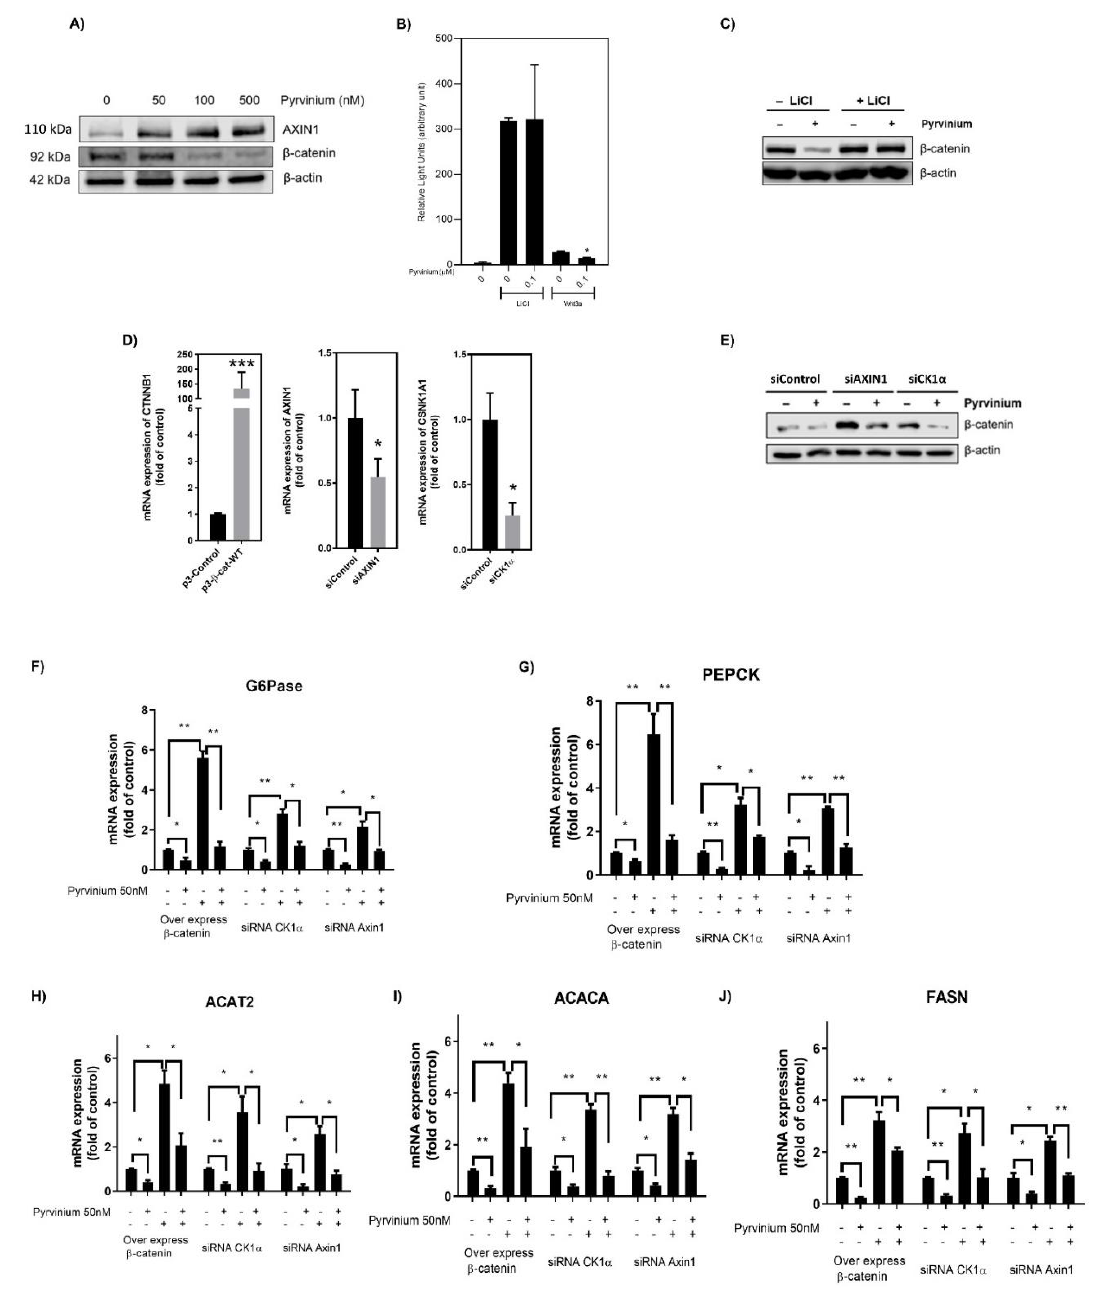
Figure 2. Role of β -catenin downregulation in the effects of pyrvinium on gluconeogenesis and lipogenesis. ( A ) Protein expression of AXIN1 and β -catenin in Huh7 cells treated with the indicated concentrations of pyrvinium for 24 h. ( B ) Dual luciferase reporter assay showing the effects by pyrvinium on Wnt signaling pathway activity in Huh7 cells co-treated with LiCl (GSK3 β inhibitor) or WNT3a-conditioned medium. The cells were transfected with TCF/LEF reporter plasmids for 16 h and treated with pyrvinium along with LiCl or WNT3a for additional 24 h. ( C ) Protein expression of β -catenin in Huh7 cells treated with 100 nM pyrvinium in the presence or absence of LiCl (25 mM) for 24 h. ( D ) Relative mRNA expression in Huh7 cells transfected with wild type β -catenin, or small interfering RNA (siRNA) against AXIN1 and CSNK1A1 ; transfection was carried out with 500 ng plasmids or 5 pmol siRNA for 48 h. ( E ) Protein levels of β -catenin in Huh7 cells transfected with siRNA AXIN1 and CSNK1A1 . ( F – J ) Relative mRNA expression of gluconeogenic genes G6Pase ( F ), PEPCK ( G ) and lipogenic genes ACAT2 ( H ), ACACA ( I ), and FASN ( J ) in Huh7 cells with or without β -catenin overexpression, knockdown of AXIN1 and CSNK1A1 , respectively, followed by treatment with 50 nM pyrvinium for 24 h. Refer to Figure 2 for cell culture conditions. * p < 0.05; ** p < 0.01, *** p < 0.001. Data are representative of at least three independent